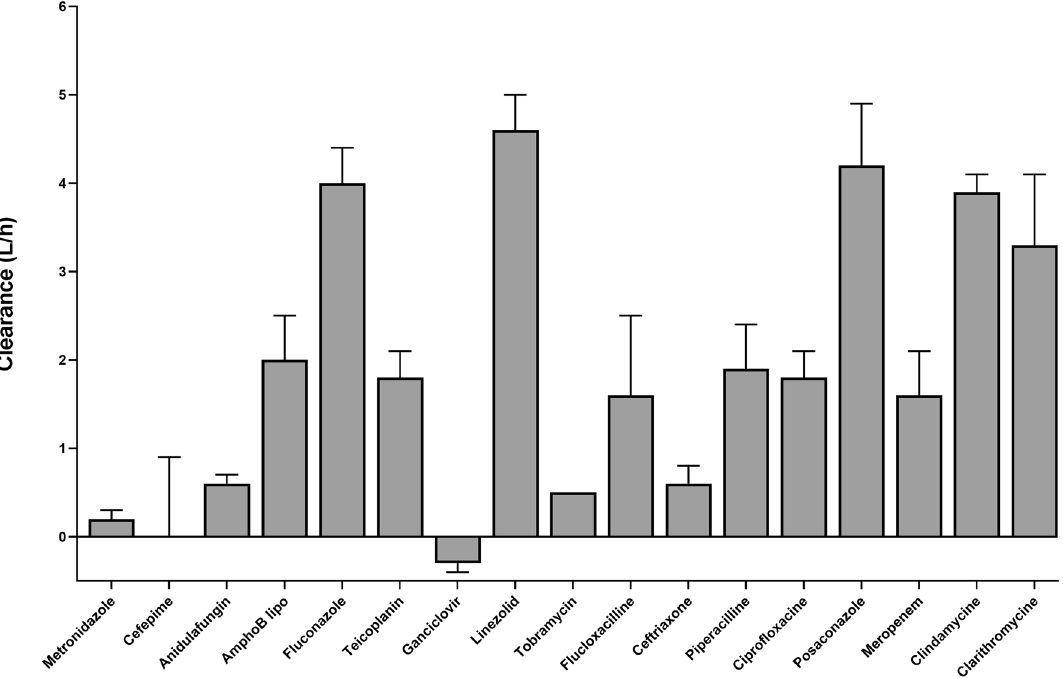
Figure 2. Total Adsorber Clearance. Clearance attributable to CytoSorb (mean and SD). Values were calculated based on pre and post adsorber measurements at different timepoints. AmphoB lipo: liposomal amphotericin B.